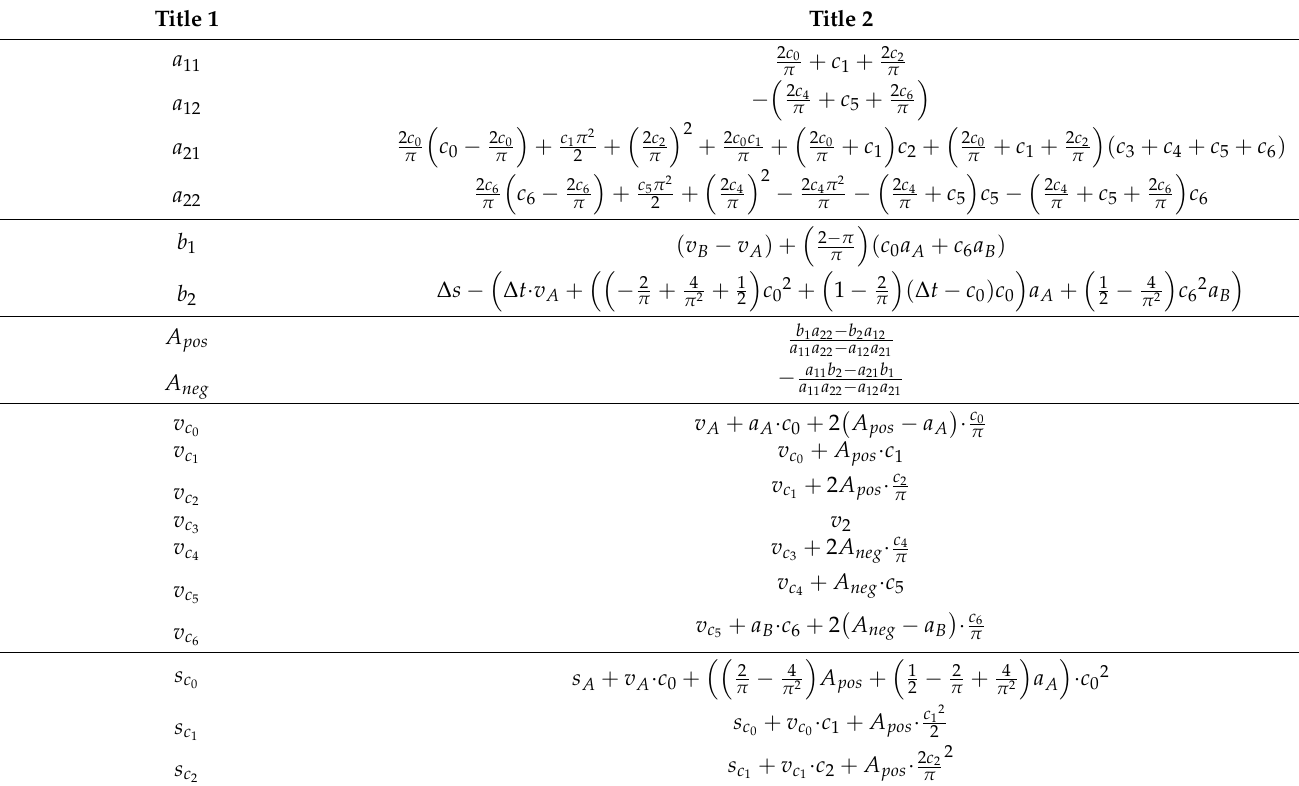
Table A1. Expressions of the vectors of cumulative partial displacements s c and cumulative partial velocities v c at the end of each section for a trapezoidal modified law of motion in the most general